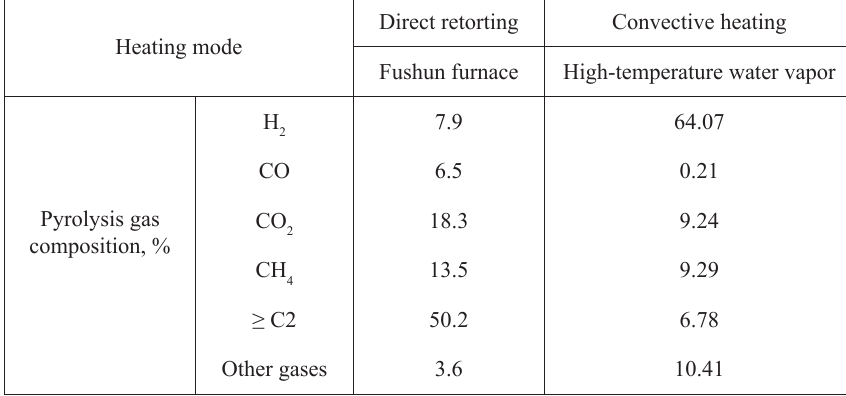
Table 2. Main component content of pyrolysis gas under different heating modes [18, 19] Direct retorting Convective heating Heating mode Fushun furnace High-temperature water vapor